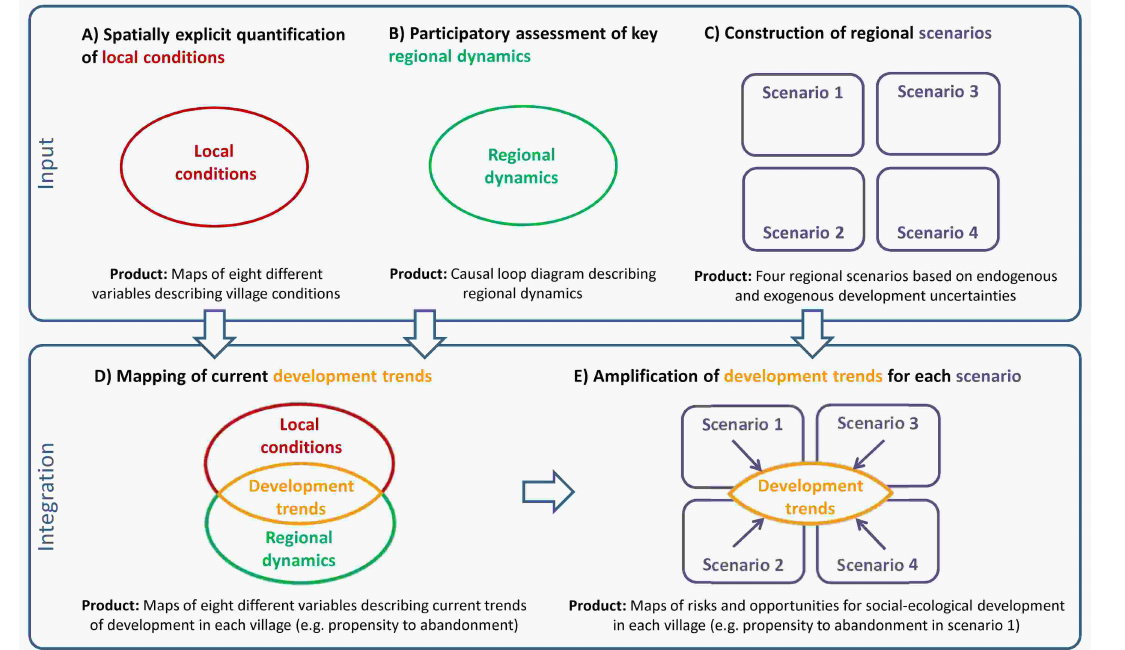
Fig. 1. Schematic summary of the five main methodological steps followed (A–E). Combining an understanding of local conditions (A) with an understanding of regional dynamics (B) resulted in spatially explicit maps depicting current social-ecological development trends in different locations (C). Maps of development trends, combined with regional scenarios (D), were then used to generate spatially explicit maps of social-ecological conditions under the different scenarios (E).